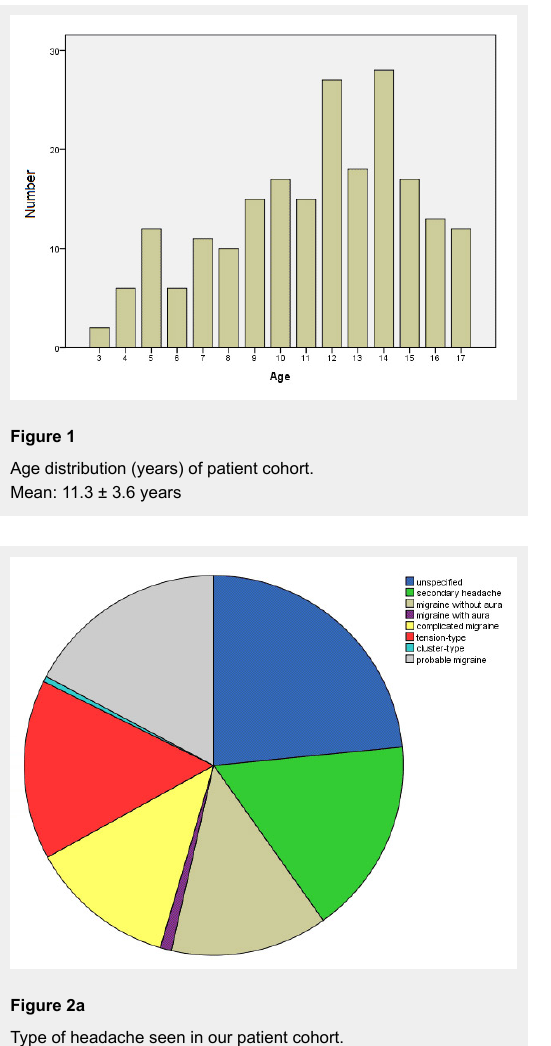
Type of headache seen in our patient cohort depending on